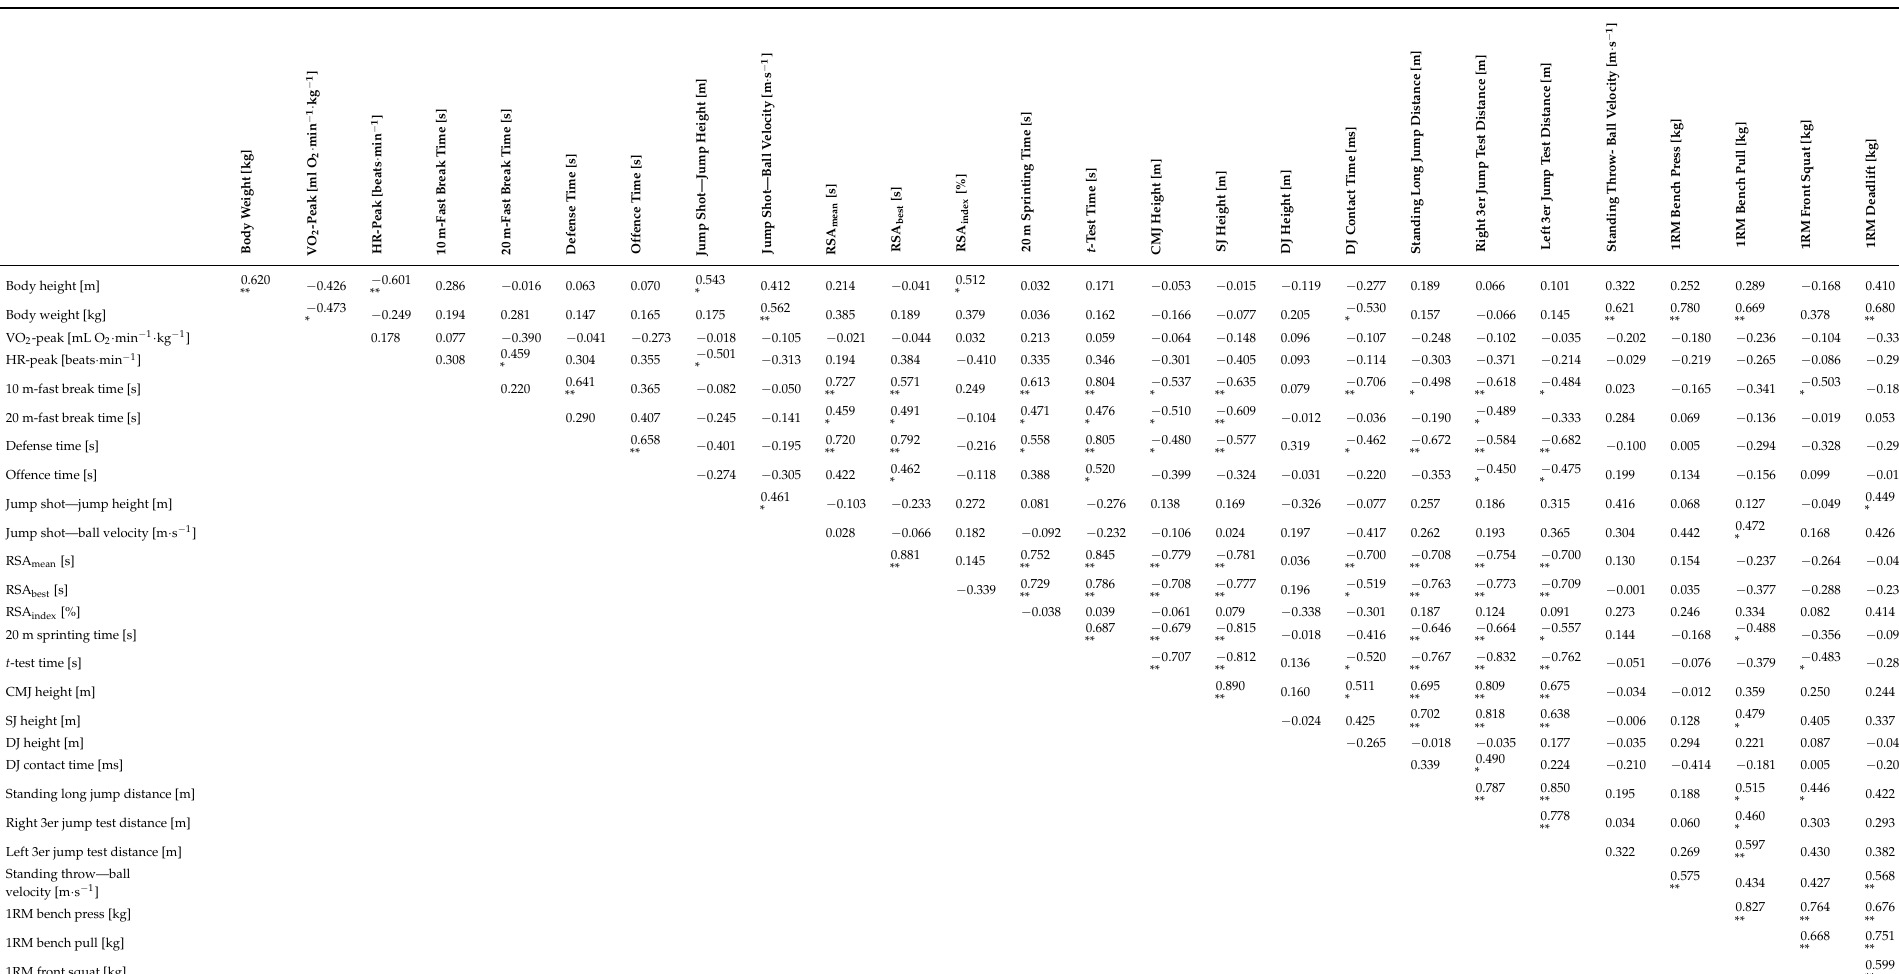
Table 2. Pearson product-moment correlation coefficients between all measured variables in the game-based performance tests and all general